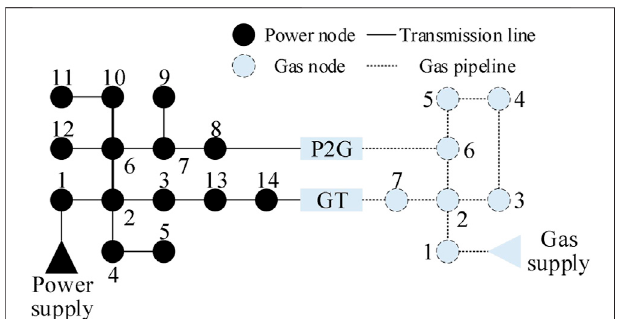
FIGURE 3 | Topology of the